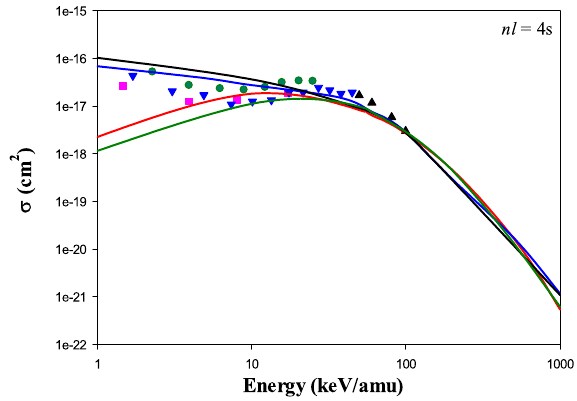
Figure 1. Electron capture cross sections into the 4 s state of the projectile in Be 4+ + H (1 s ) collision as a function of the impact energy. Solid red line: present CTMC results, solid black line: present target-centered QCTMC results, solid green line: present projectile-centered QCTMC results, solid blue line: present target and projectile centered QCTMC results, pink squares: AOCC results of Fritsch 5 , green circles: QMOCC results of Harel et al. 4 , black triangles: BCCIS results of Das et al. 14 , blue inverse triangles: OEDM results of Errea et al. 13